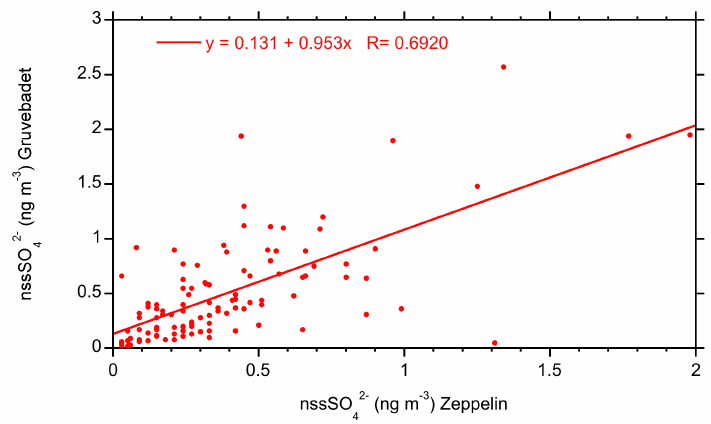
Figure 19. Correlation between nss-SO 2 −